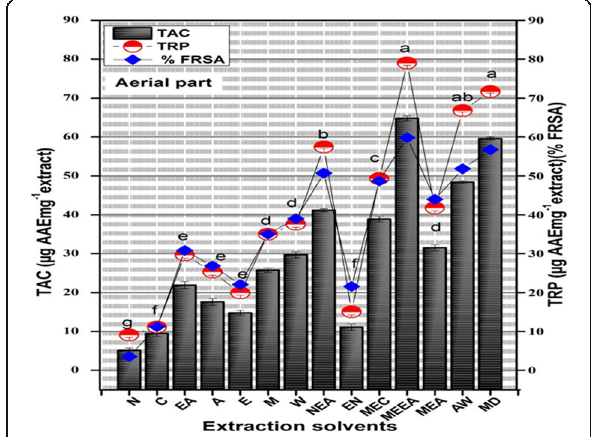
Table 2 HPLC-DAD analysis of Methanol Ethyl Acetate (MEA) Extracts of Atriplex lasiantha Standard